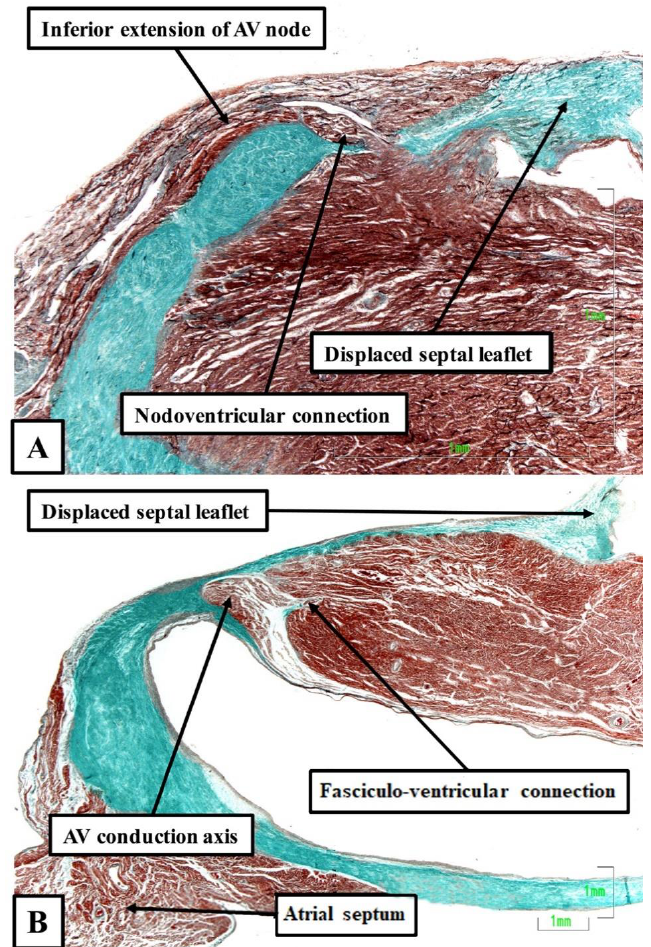
Figure 4 . Nodo-ventricular and fasciculo-ventricular pathways: Both sections were taken from human hearts shown at autopsy to exhibit Ebstein’s malformation. ( A) shows a direct nodoventricular connection between the inferior rightward extention of the atrioventricular (AV) node and the crest of the ventricular septum, while ( B) shows a fasciculo-ventricular connection given off from the conduction axis prior to the origin of the right bundle branch. The sections were stained using the trichrome technique.